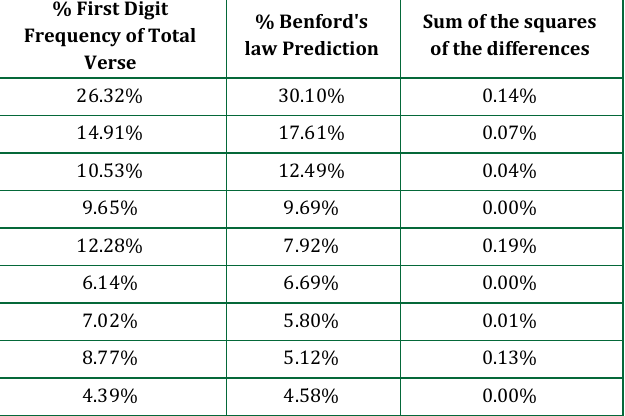
Table 3: Sum of the squares of the differences between frequency of total verse and the Benfo rd’s law prediction.